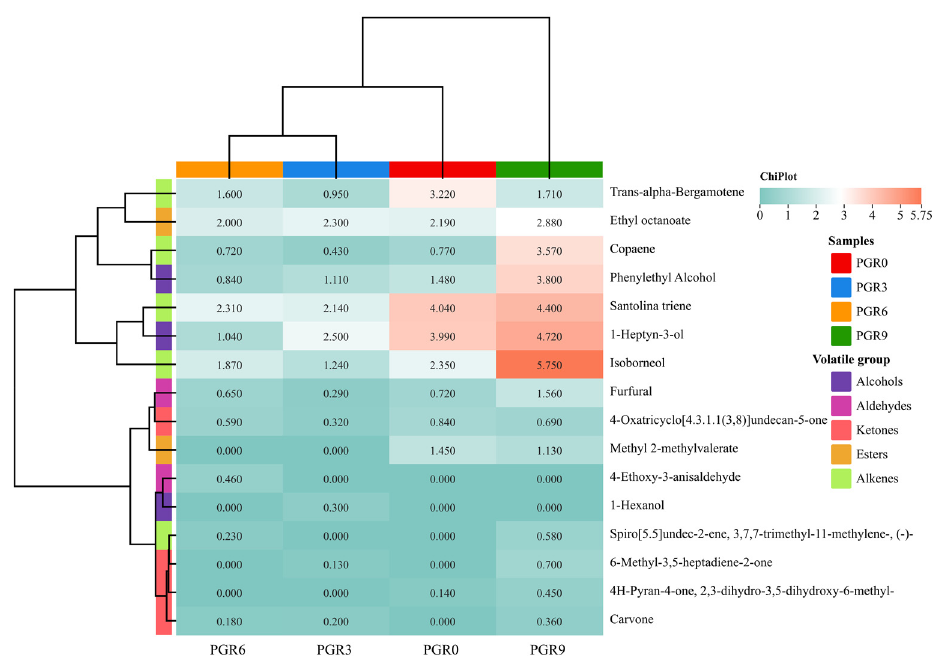
Figure 4. Volatile profiles of wheat bread enriched with different addition amounts of PGR flour. PGR0: without PGR flour; PGR3: with 3 g/100 g PGR flour; PGR6: with 6 g/100 g PGR flour; PGR9: with 9 g/100 g PGR flour.